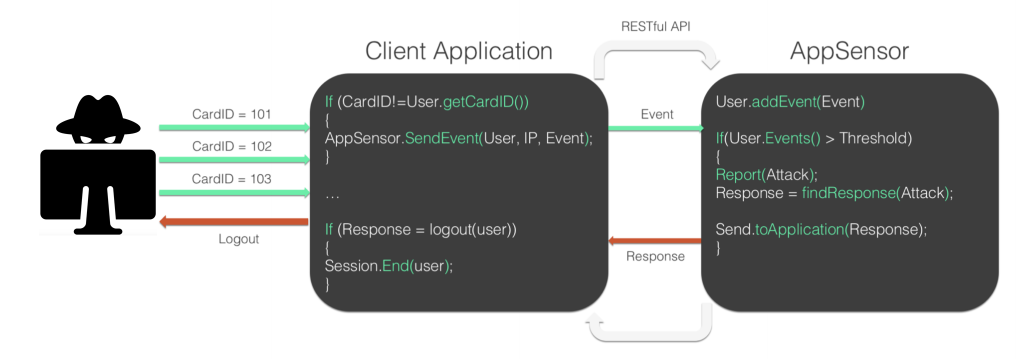
Figure 4. AppSensor CardID